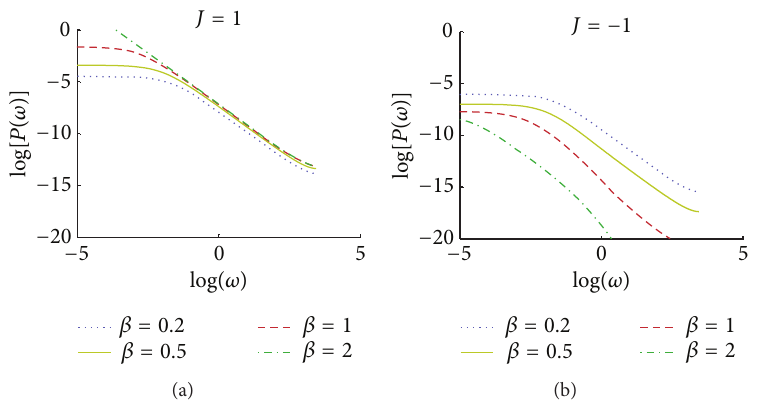
Figure 2: Temperature dependent power spectrum for a pair of fluctuators, with 𝛾 1 = 0.1 and 𝛾 2 = 0.2 , shown for (a) 𝐽 = 1 ferromagnetic interaction and (b) 𝐽 = −1 antiferromagnetic